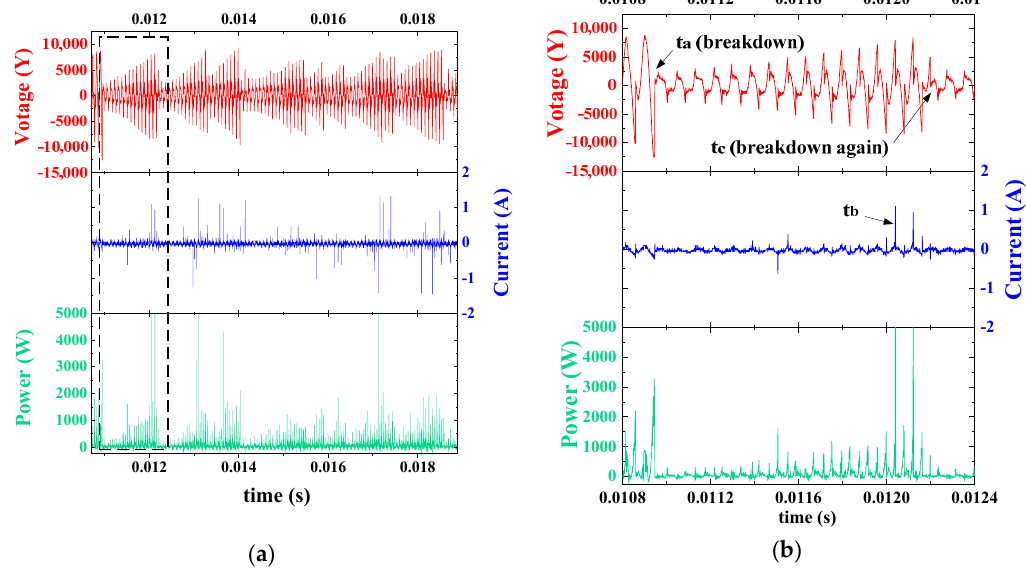
Figure 7. ( a ) Voltage, current, and power waveforms of the gliding arc discharge when average flow rate in stable mode was 120SLM. ( b ) Zoomed-in view voltage, current, and power waveforms (from t = 0.0108 s to t = 0.0124 s).